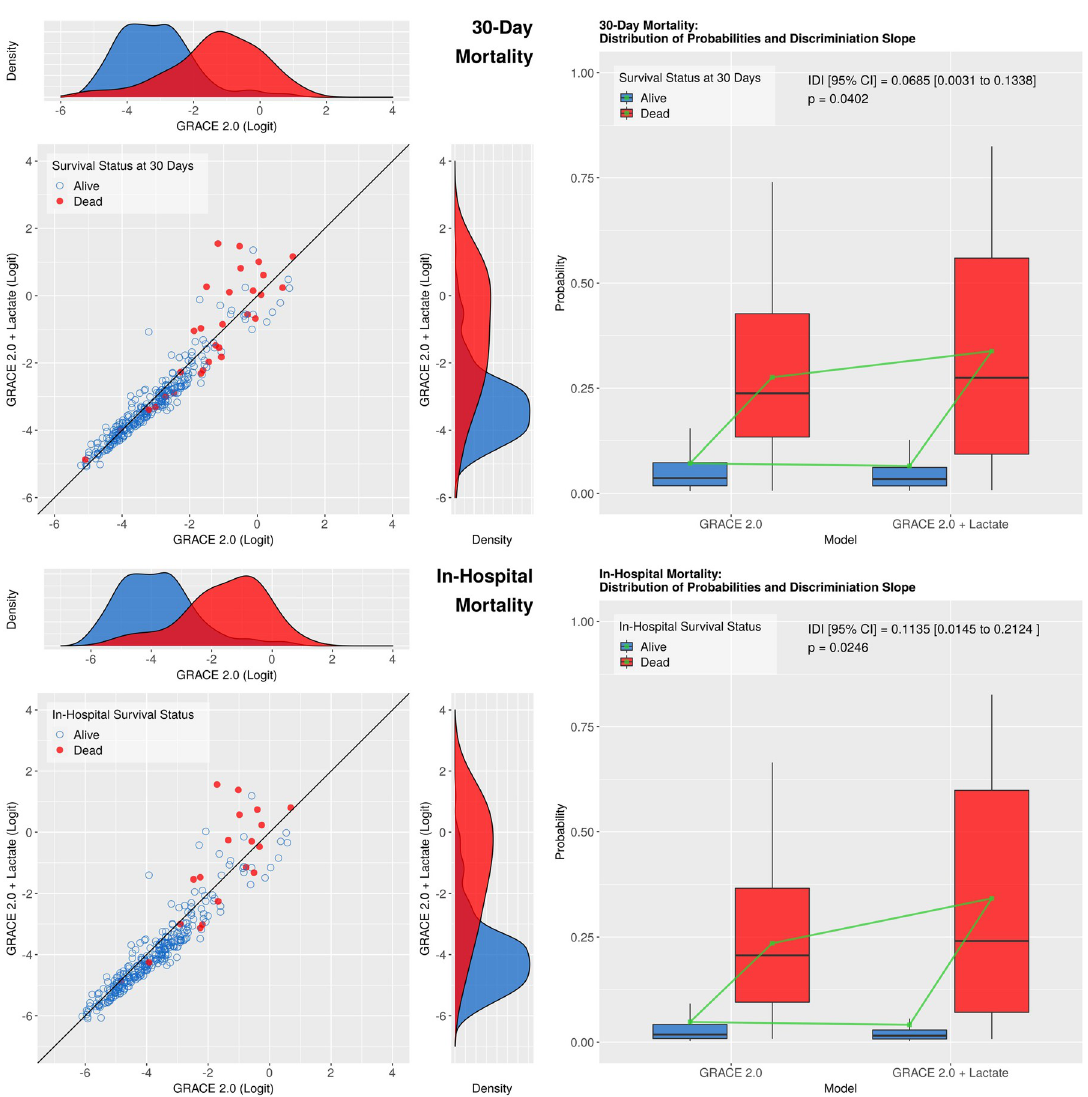
Fig 3. Exploratory analysis: Scatter / density (left panels) and box-and-whisker (right panels) plots for 30-day (upper panels) and in- hospital (lower panels) mortality. The left panels show combined scatter and density plots of the two models according to survival status. The diagonal line represents identical predictive ability. With the inclusion of lactate, the probability of dying within 30 days / during hospital stay was shifted downwards in most survivors (blue circles), whereas the majority of non-survivors (red dots) were shifted towards higher risk. The change in density plots also suggest an increased discriminatory power of the expanded